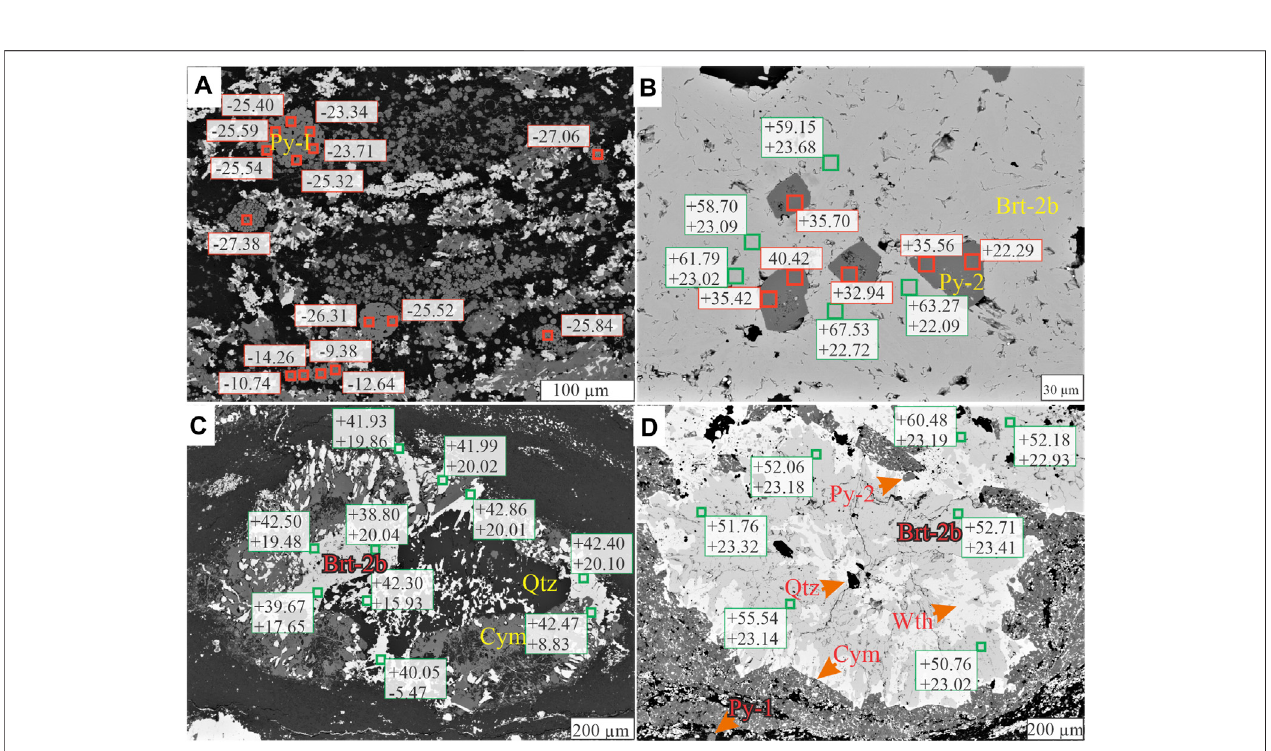
FIGURE13| BSEimages annotatedwithpyrite δ 34 Svalues(redsquares)andbarite δ 34 Sand δ 18 Svalues(green squares). (A) Pyriteframboidsand polyframboids (Py-1) in a matrix replaced by cymrite (dark grey) and witherite (white). (B) Euhedral pyrite (Py-2) intergrown with Brt-2b. (C) Nodular barite ((Brt-2b) replaced by quartz (Qtz) and cymrite (Cym). (D) Witherite (Wth) replacement of nodular barite (Brt-2b), both rimmed by cymrite (Cym).